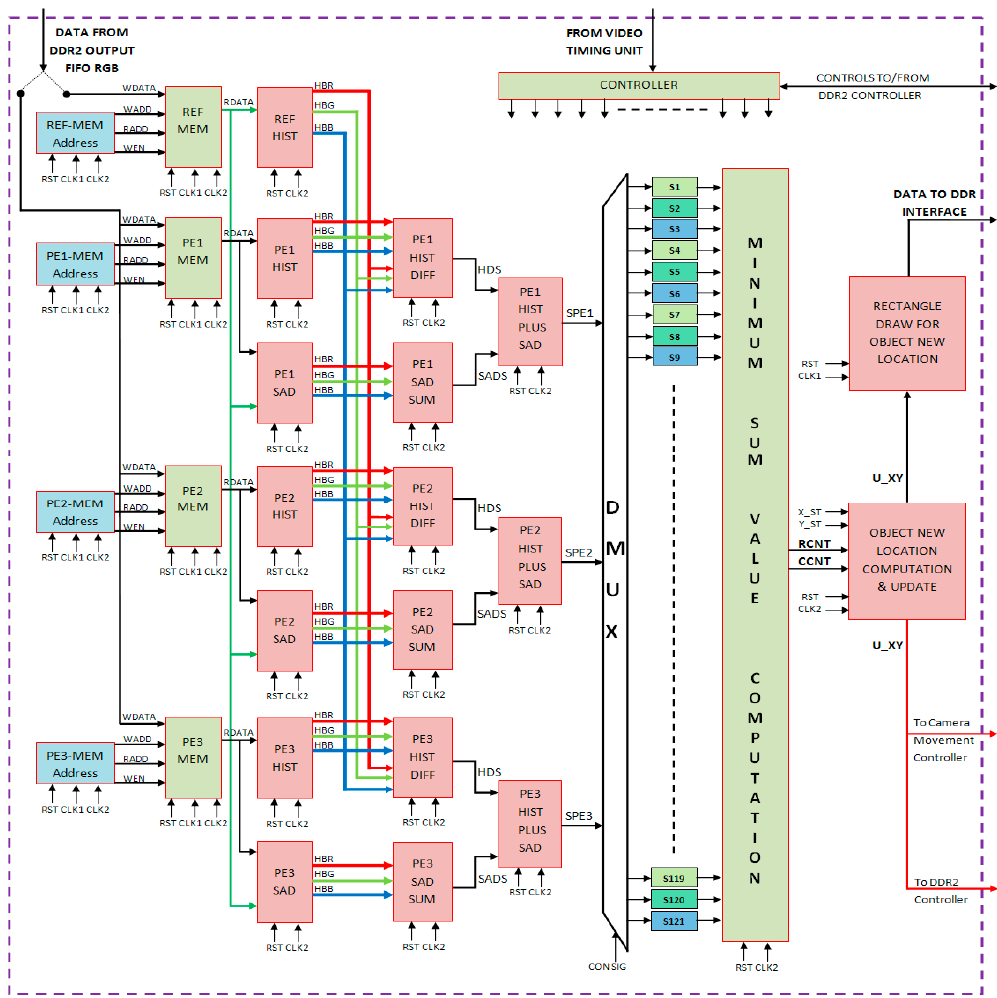
Figure 4. VLSI architecture for object tracking scheme proposed, designed and implemented in the